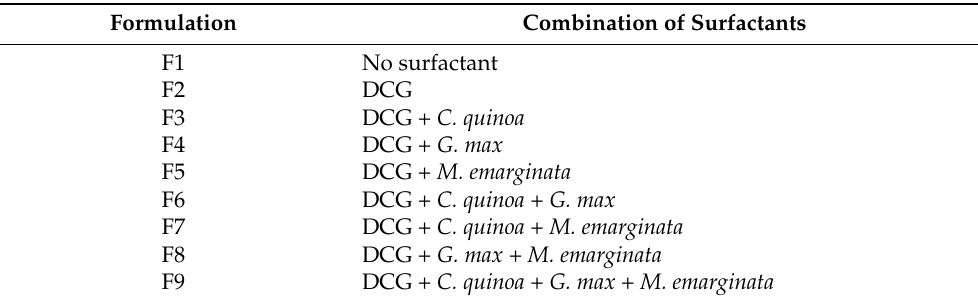
Table 7. Composition of formulations, showing primary and secondary